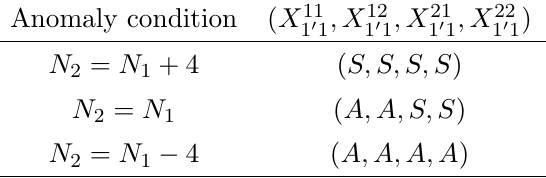
Table 8. The various unoriented projections b (cid:10) of the magnetic C = Z 0 groups U( N 2 ) (cid:2) U( N 1 ). \A" stands for \Antisymmetric representation", while \S" for \Symmetric representation".